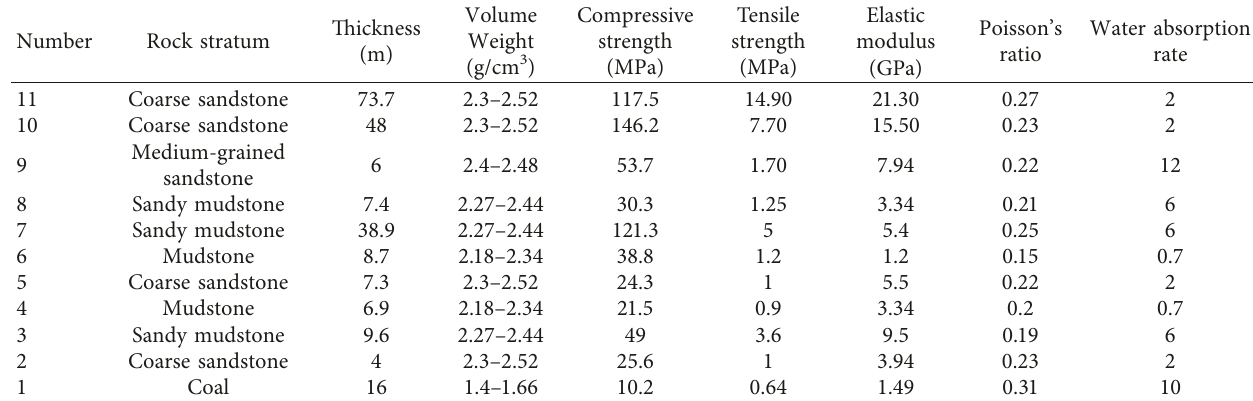
Table 4: Overlying strata structure of working face.